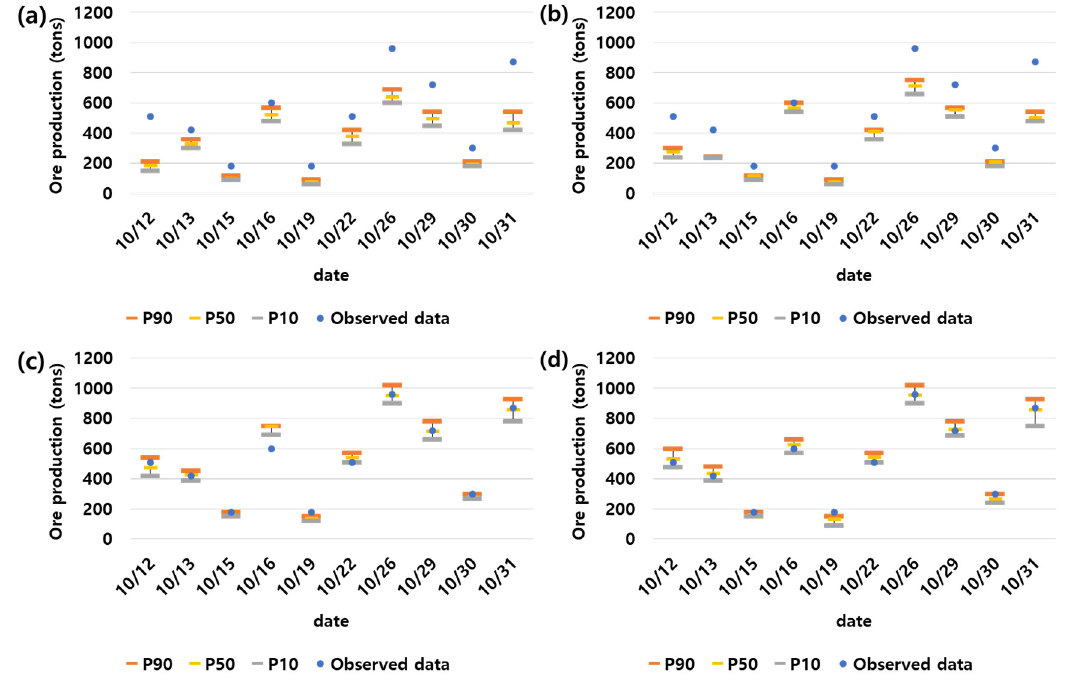
Figure 9. Comparison of the simulation and haulage operation results (observed) for ten days (Month/Day) in October 2018 for ( a ) uniform distribution, ( b ) triangular distribution, ( c ) normal distribution, and ( d ) observed probability distribution.